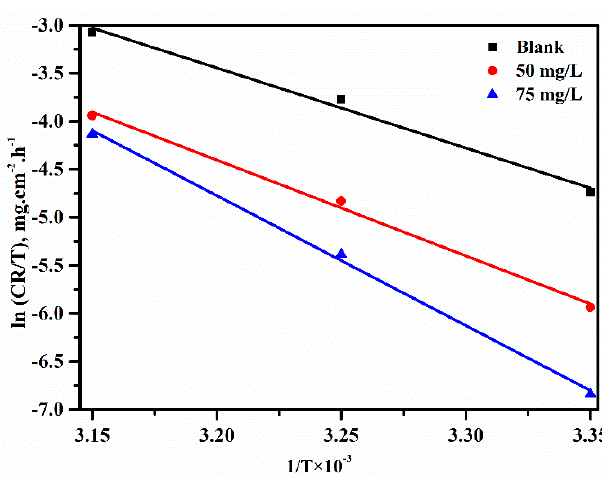
Figure 8. Arrhenius plots of the corrosion rate (CR / T) in an HCl solution in the absence and presence of Lignin-DMC.